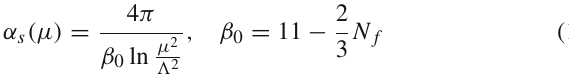
300GeV (lower). Each figure shows the distribution for cutoff values of Q 0 = 1GeV (red solid line), Q 0 = 1 . 6GeV (green dashed line), and Q 0 = 2GeV (blue dotted line),